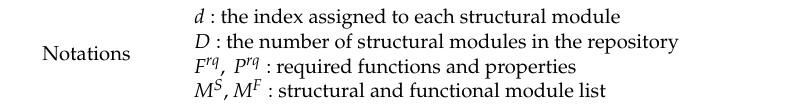
Table 2. Process to revise a selected